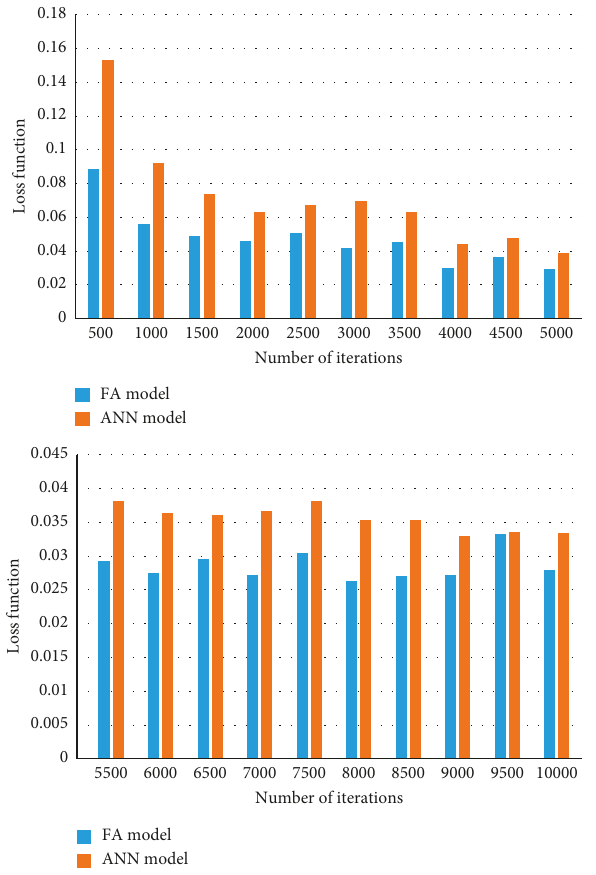
Figure 9: Loss function data comparison. Table 2: Data results.